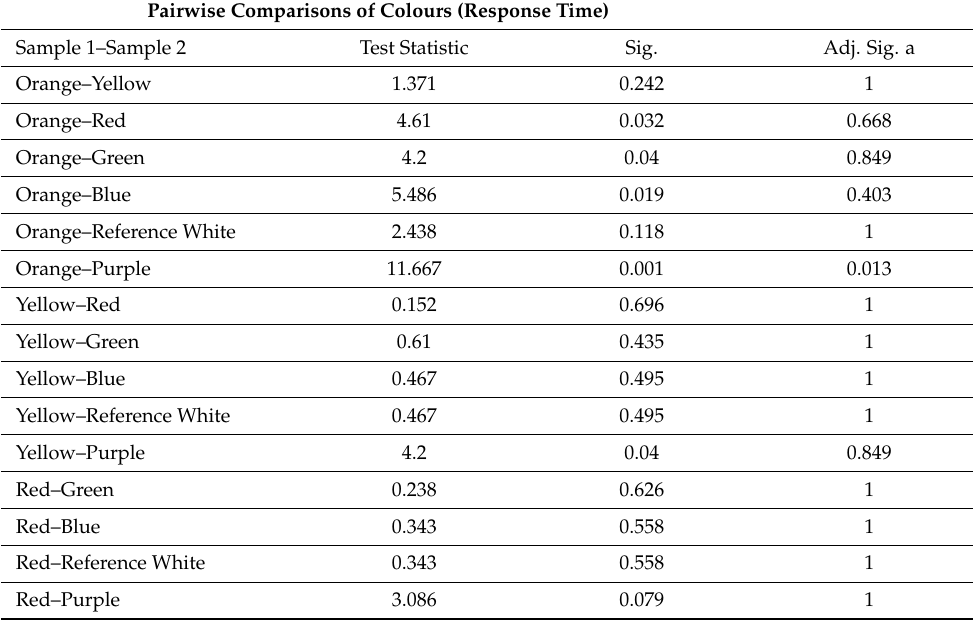
Table A4. Effects on response time (general